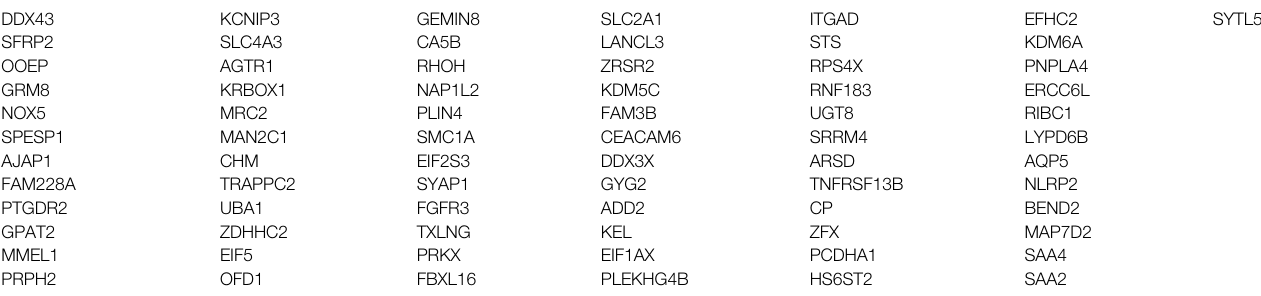
TABLE 1 | Top differential genes between males ’ and females ’ lung tissues. DDX43